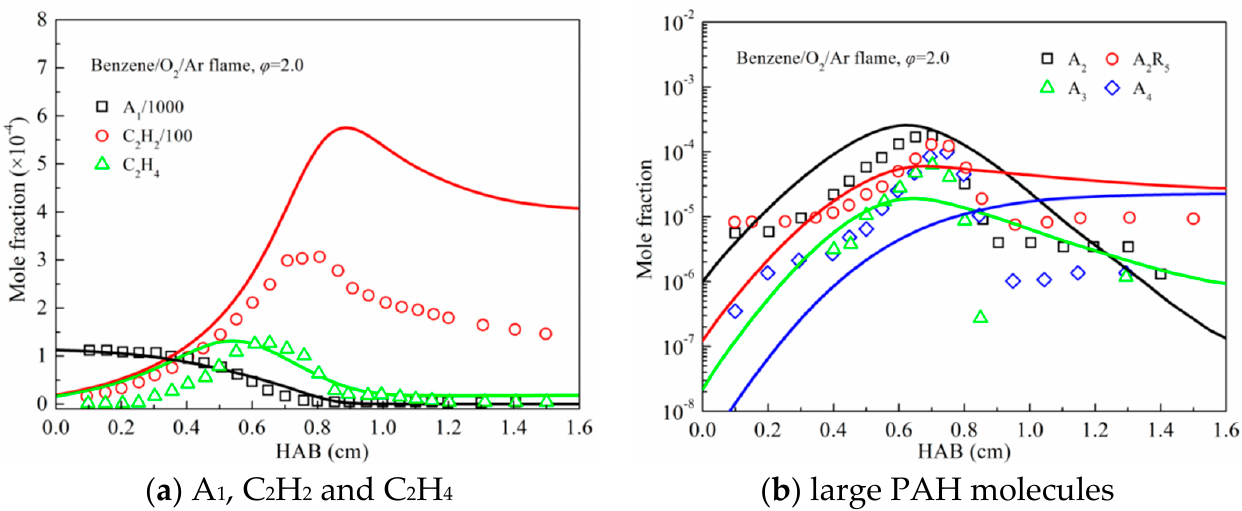
Figure 10. Measured [48] (symbols) and predicted (lines) species profiles in the premixed benzene flame with ϕ = 2.0.